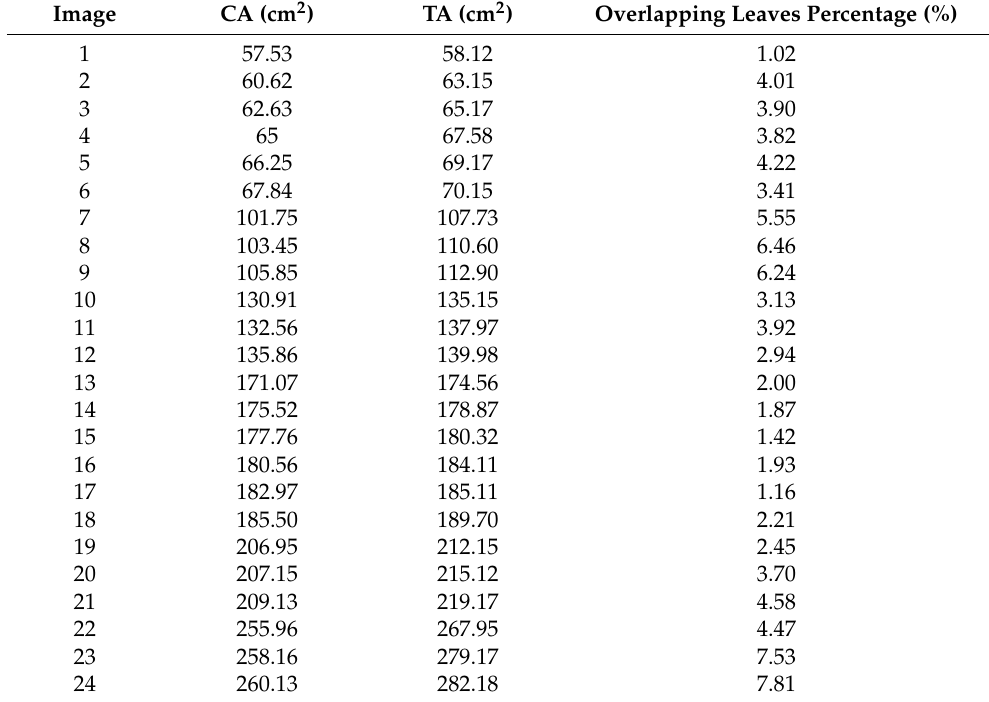
Table 1. Comparison of results, measured by the proposed algorithm and curvimeter